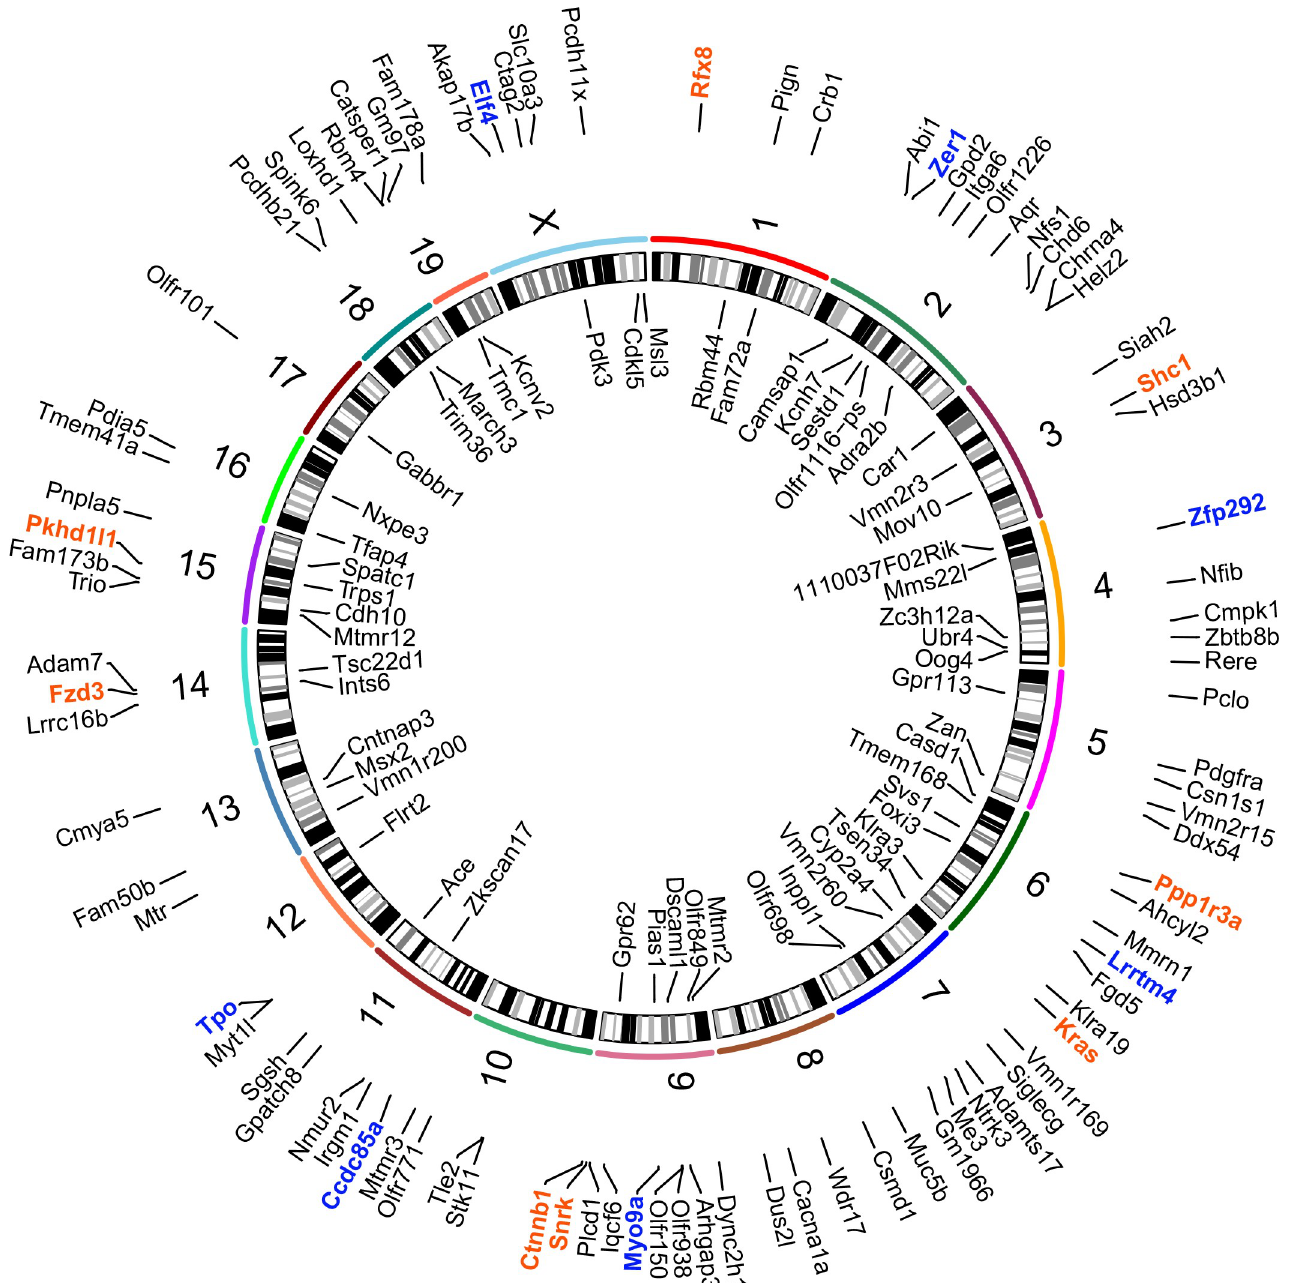
Fig 1. Metastasis-specific SNVs can be found at high allele frequency in the PyMT model. Circos plots showing names and chromosomal location of genes identified by exome- and RNA-seq with metastasis-specific SNVs (orange: recurrent single strain, blue: recurrent in both strains, and black: singly mutated) from the PyMT